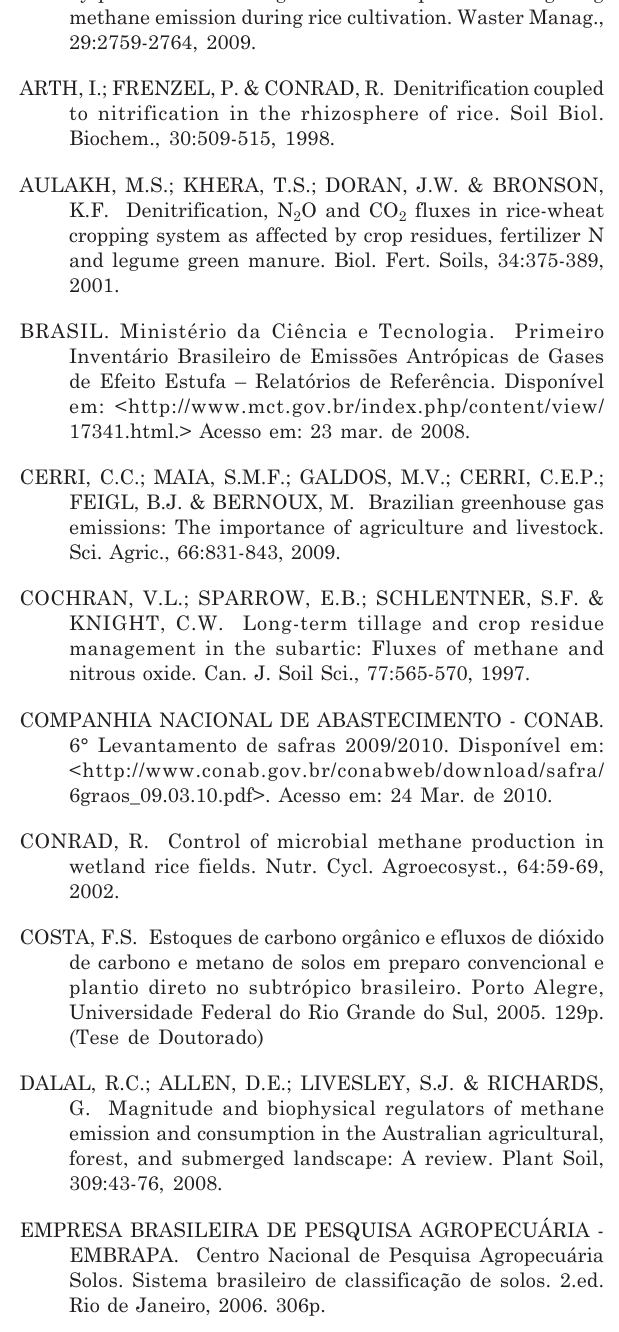
and N O emissions, 4 2 , from a flooded 2